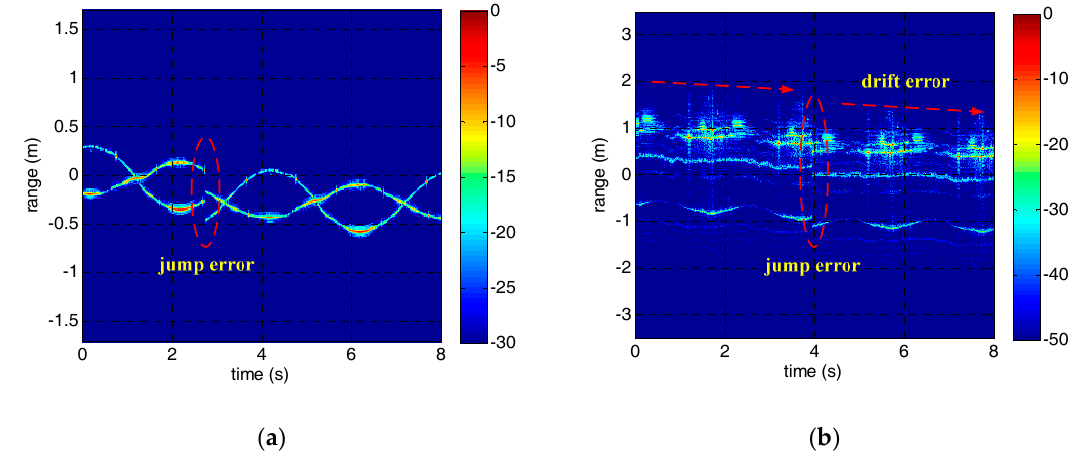
Figure 6. The HRRPs of the micro-motion targets after adjacent correlation correction. ( a ) The HRRP of the corner reflectors. ( b ) The HRRP of the warhead model.